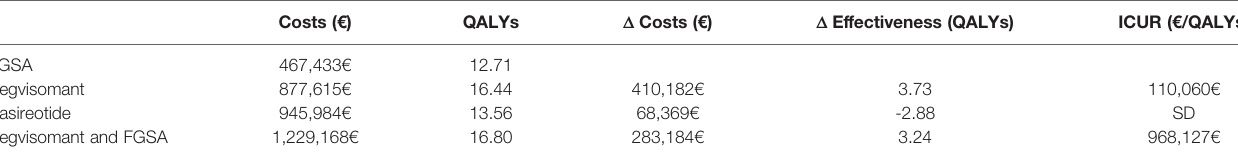
TABLE 8 | Scenario 2